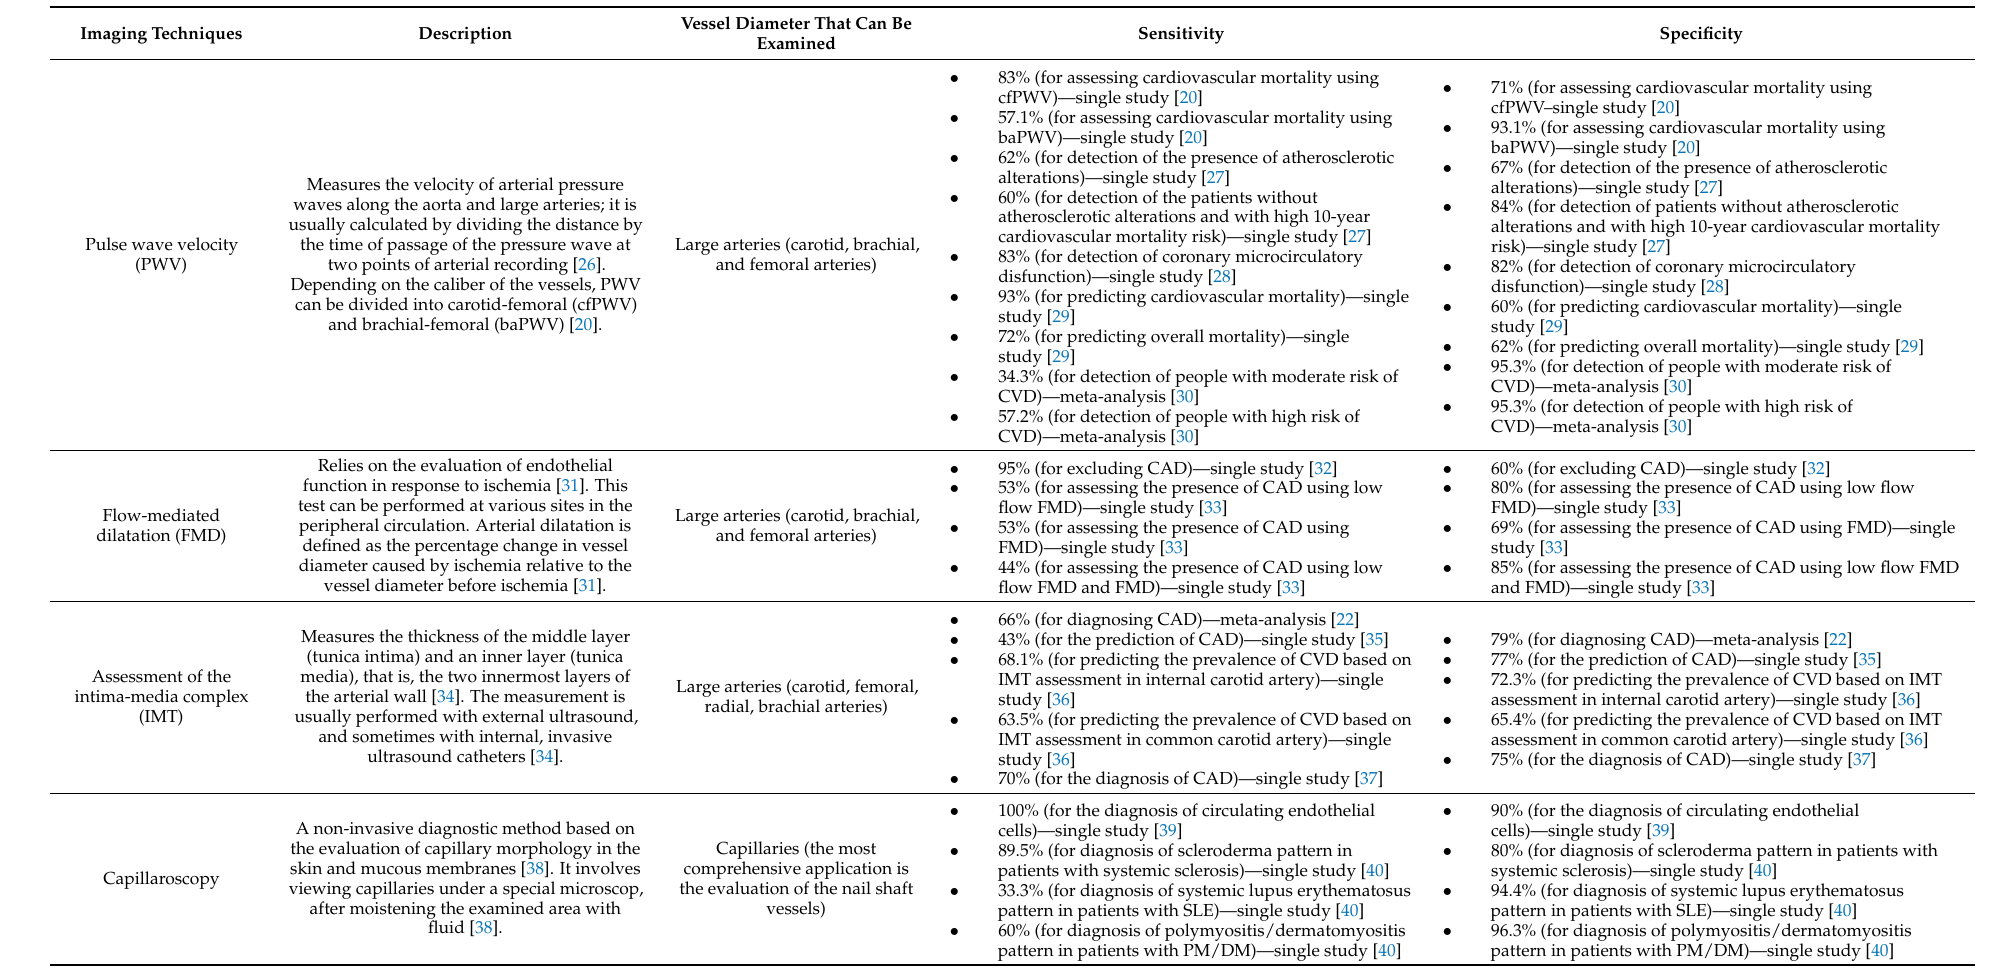
Table 1. Diagnostic tools of vascular aging in dependence on vessel